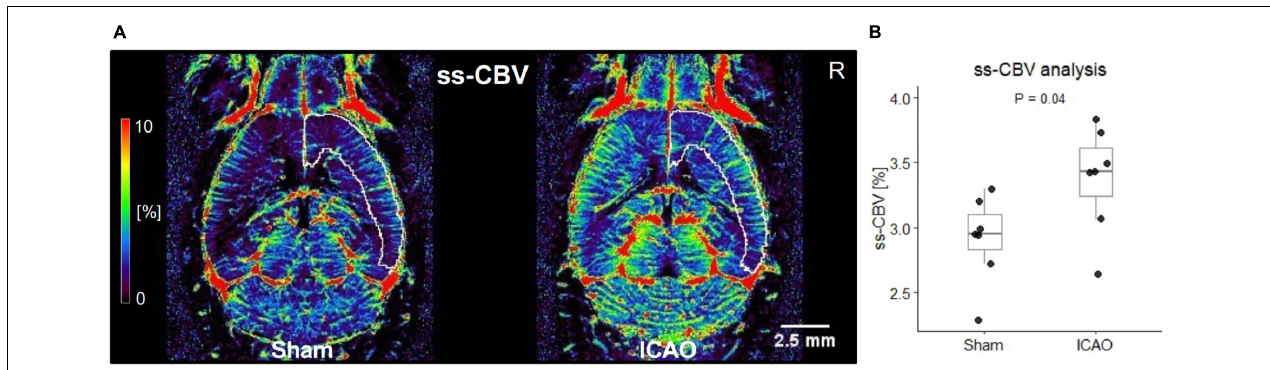
FIGURE 2 | Steady state-cerebral blood volume (ss-CBV) analysis 21 days after ICAO or Sham. (A) Iron oxide nanoparticle-based ss-CBV maps color-coding the fraction of blood volume per voxel brain tissue in percent (%). The white frames illustrate the right-sided neocortex as defined by the Allen Mouse Brain Atlas. (B) Group comparison in the right-sided neocortex ipsilateral to the permanent ICA-occlusion shows an increase in ss-CBV after ICAO ( n = 7 per group).